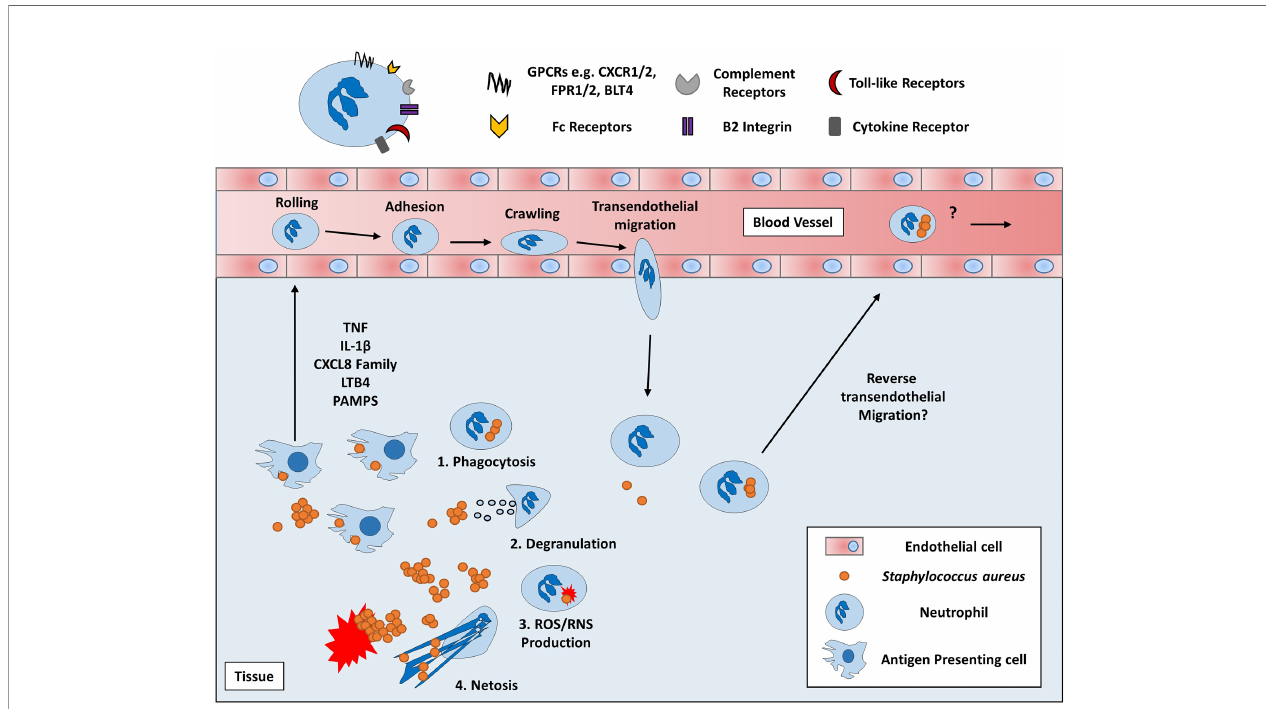
FIGURE 2 | Overview of Neutrophil chemotaxis and effector functions. Neutrophils are circulatory immune cells which respond to host or pathogen derived chemoattractants using various receptors such as chemokine receptors (e.g. CXCR2) and pathogen recognition receptors (e.g. FPR2) (69, 70). Proin fl ammatory cytokines, chemokines, and lipid mediators, such as TNF, CXCL8 and leukotriene B 4 (LTB 4 ) respectively, are produced by local immune and non-immune cells which recruit PMN from the peripheral blood (71, 72). Initially, PMN slow their passage through the blood via weak interactions with the endothelium causing PMN to roll along the surface of the blood vessel. PMN then begin to adhere to the endothelium through stronger B 2 integrin interactions via I-CAM1 molecules expressed on the surface of endothelial cells (73). Ultimately, PMN crawl across the endothelium toward the chemotactic gradient until they traverse through the blood vessel to the site of infection via transendothelial migration. Once at the site of infection, PMN begin to exert their various effector functions which include 1) phagocytosis via complement and Fc receptors to eliminate S. aureus via several intracellular mechanisms 2) releasing primary, secondary and tertiary granules containing antimicrobial peptides such as cathepsins, defensins and gelatinases into the extracellular space or phagosomal compartment, 3) Generating reactive oxygen or nitrogen species via NADPH oxidase, myeloperoxidase and nitric oxide synthase and 4) the release of uncondensed chromatin imbued with histones and antimicrobial peptides in a process of cell death known as NETosis (74, 75). Despite these effective killing mechanisms, S. aureus can survive intracellularly within PMN and could potentially induce rTEM in PMN to enter the peripheral blood and disseminate to secondary sites (6, 8,